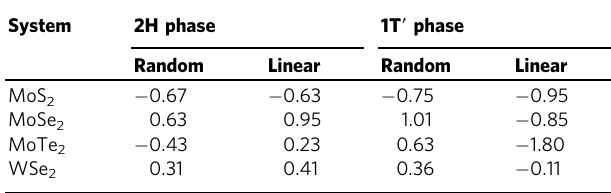
Oxygen binding energies ( Δ E/O atom) for different 2D MX 2 phases in the unit of